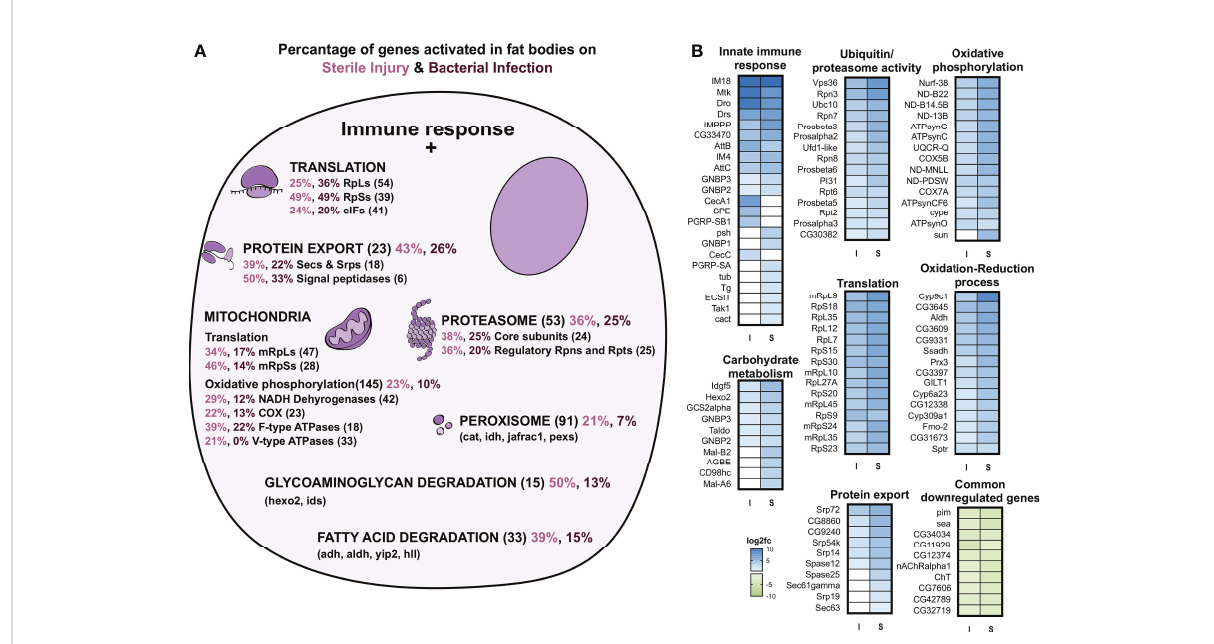
FIGURE 3 GO term analyses of genes regulated in the fat body in response to infection and sterile injury. (A) Summary of the processes activated on top of the classic antibacterial response in fat body cells on bacterial infection or sterile injury. For each process, the total number of genes associated with the process is shown in brackets next to it. Out of these genes, the percent activated in bacterial infection are shown in maroon and in sterile injury in pink color. For some processes, the subunits are shown (like the RpLs and RpSs for translation) and for some processes, some selected genes are shown (like hexo2 and ids for glycosaminoglycan degradation). (B) The log 2 fold changes of selected genes from the processes shown in A are plotted as heatmaps for bacterial infection (I) and sterile injury(S). For the innate immune response all associated activated genes are shown, while for the rest, the top 10-15 genes were picked based on the magnitude of fold change expression. The top 10 commonly downregulated genes in I and S with the highest fold change in expression are also